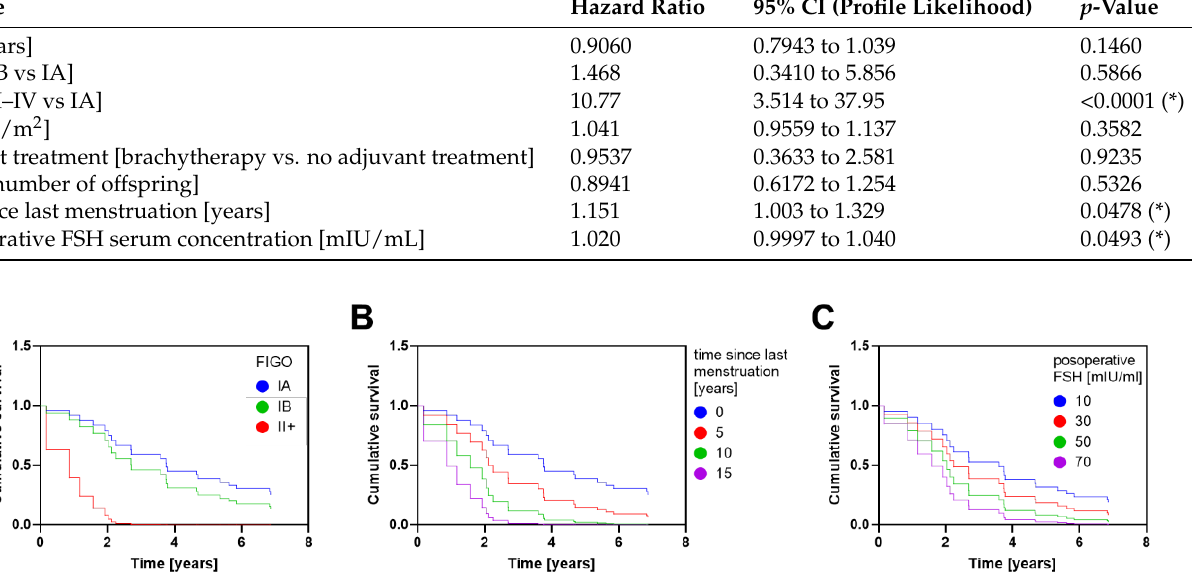
Figure 1. Estimated survival curves generated from the proposed Cox proportional hazards model for patients with different FIGO stage ( A ), time since menstruation ( B ), and postoperative FSH serum concentrations ( C ). For each plot, the variables not depicted on the plot were set either to zero (for continuous variables) or to the reference value (for categorical variables).